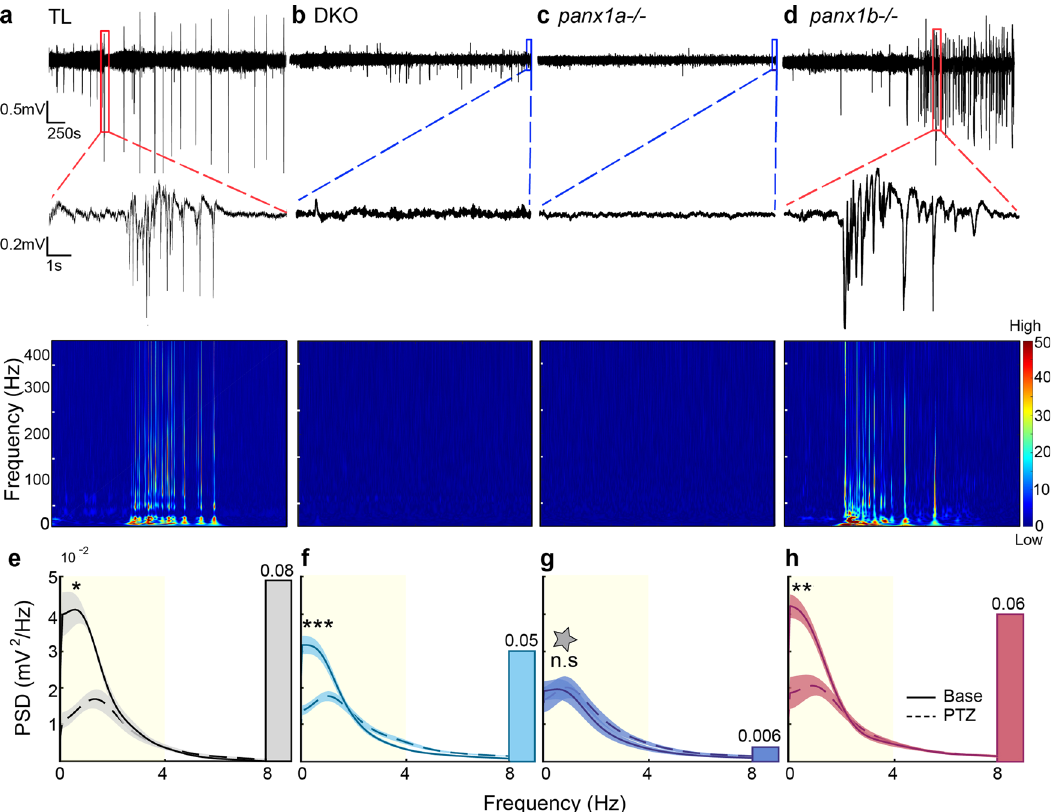
Fig. 2 Spectral Analysis of LFPs revealed unique differences in larvae. Representative 1h long LFP traces with PTZ treatment: a TL ( b ) DKO, ( c ) panx1a − / − , and ( d ) panx1b − / − . TL and panx1b − / − traces showed typical seizure-like events. Single events were highlighted by red dotted lines and magni fi ed. Blue dotted lines highlight a lack of seizure-like activity in DKO and panx1a − / − larvae. Spectrograms below the traces showed low and high-frequency power increases during seizure-like events for TL and panx1b − / − . Scale bar: A value of 0 (blue) is low, and a value of 50 (red) is high. e – h Power spectral density (PSD, mV 2 /Hz) measured across frequencies revealed no signi fi cant differences in baseline (dotted lines) frequencies for all genotypes ( P = 0.69; Kruskal – Wallis test). e TL, gray; f DKO, light blue; g panx1a − / − , dark blue; h panx1b − / − , magenta. The power was signi fi cantly increased in the delta band (1 – 4Hz) after PTZ treatment (solid line) for all genotypes except panx1a − / − (TL: P = 0.02, n = 7; DKO: P = 5.0×10 − 4 , n = 12; panx1a − / − : P = 0.6, n = 8; panx1b − / − : P = 3.9×10 − 3 , n = 9; Wilcoxon signed-rank test). The PSD was plotted as an average across traces with the shaded regions indicating±s.e.m. Changes in delta power were quanti fi ed from the areas under the curves (AUC; highlighted in yellow) of the power spectrum. The changes in AUCs are represented as bar graphs inserted to the right of the power spectra. TL showed the greatest change in delta, followed by panx1b − / − ( P = 1.0), and DKO ( P = 0.4). Panx1a − / − exhibited insigni fi cant changes ( P = 2.3×10 − 3 ; Dunn ’ s multiple comparisons) and maintained delta power throughout recordings. N = number of larvae. Scale bars: top = 0.5mV by 250s and bottom = 0.2mV by 1s. *** P <0.001, **** P <0.0001, gray star - P = 2.3×10 − 3 compared to TL with